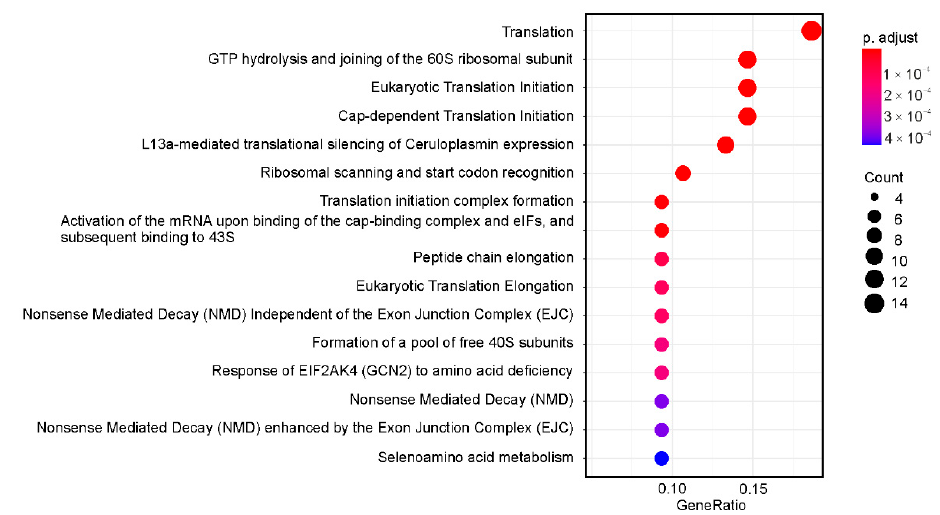
Figure 4. Dotplot enrichment map showing cellular pathways associated with up-regulated GDTEs from HEK293 cells knocked down of eL38. The colors of the points depend on the p .adj values, and their sizes are determined by the number of GDTEs associated with the corresponding pathways (color and dot size keys are shown on the right).